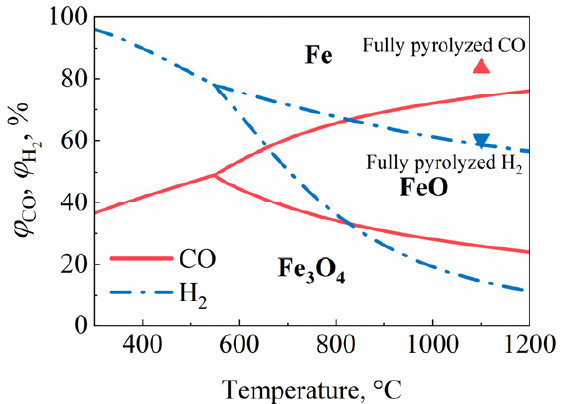
Figure 4. Reductive properties of coal pyrolytic gas.